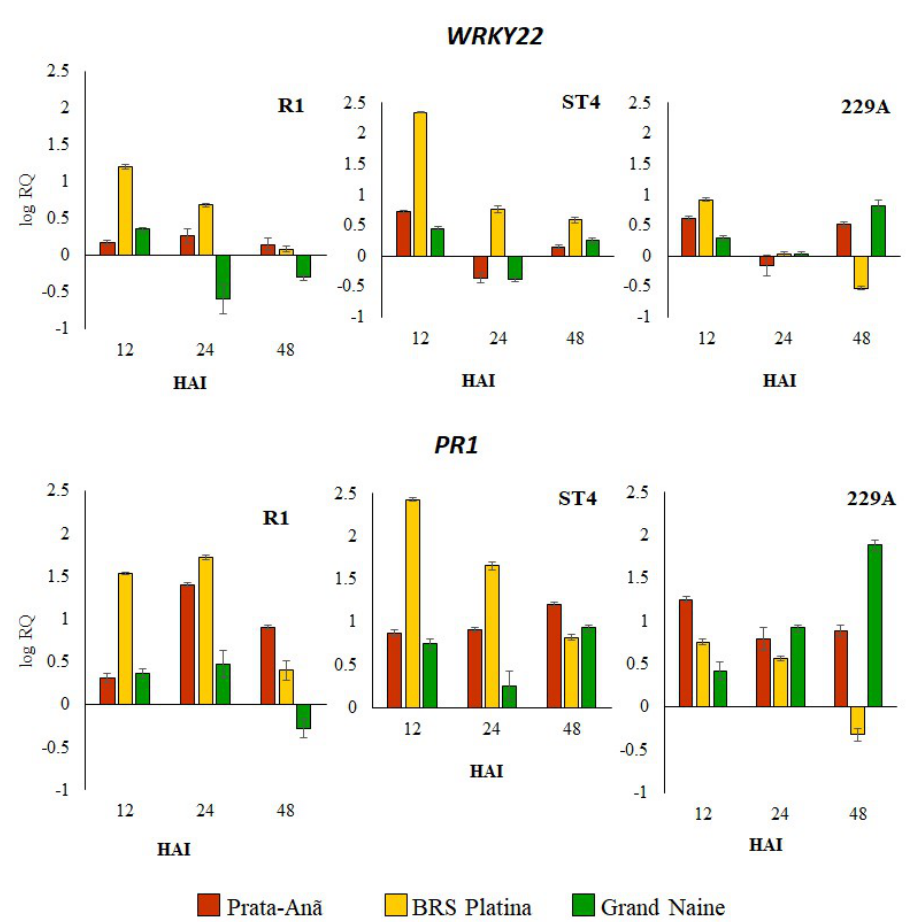
Figure 3. Relative expression levels of two defense-related genes in banana genotypes at 12, 24 and 48 h after inoculation (HAI with Fusarium oxysporum f. sp. cubense races 1 (Foc R1), subtropical 4 (Foc ST4) and isolate 229A. The relative expression levels of the defense-related gene transcription factor WRKY22 and protein-related pathogenesis 1-like PR1 were analyzed by RT-qPCR. The data represent the means ± standard deviations of three biological replicates and three technical replicates. QR values correspond to genes with differential expression at 12, 24 and 48 h after inoculation (HAI) compared to 0 HAI (non-inoculated plants).